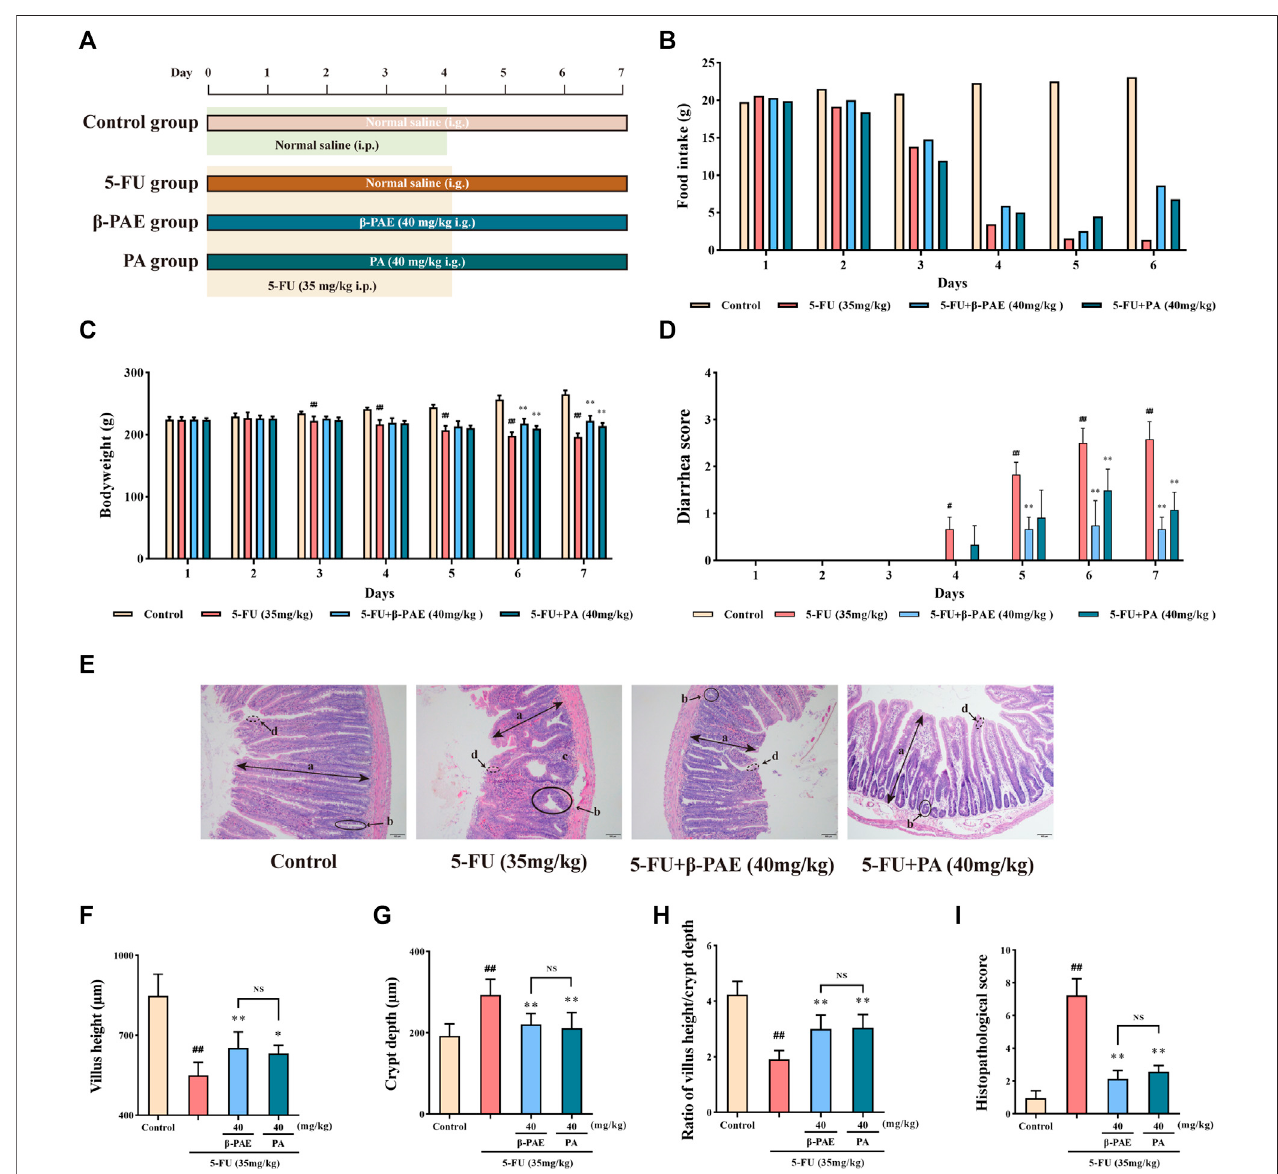
FIGURE 8 | Effects of β -PAE and PA on the body characteristics and small intestine histopathology. (A) Comparative study scheme of β -PAE and PA treatment in IM rats; (B) Food intake; (C) Bodyweight; (D) Diarrhea scores; (E) Small intestine sections showed by H&E staining (magni fi cation 100x), the symbol are as follows: (a) villus; (b) crypt lumen; (c) in fi ltration area; (d) microvillus; (F) Villus height; (G) Crypt depth; (H) Ratio of villus height/crypt depth; (I) The histopathological score of small intestine H&E staining. Data are shown as mean ± SD ( n (cid:2) 6 − 7). # p < 0.05, ## p < 0.01 versus control group; * p < 0.05, ** p < 0.01 versus 5-FU group. NS, not statistically signi fi